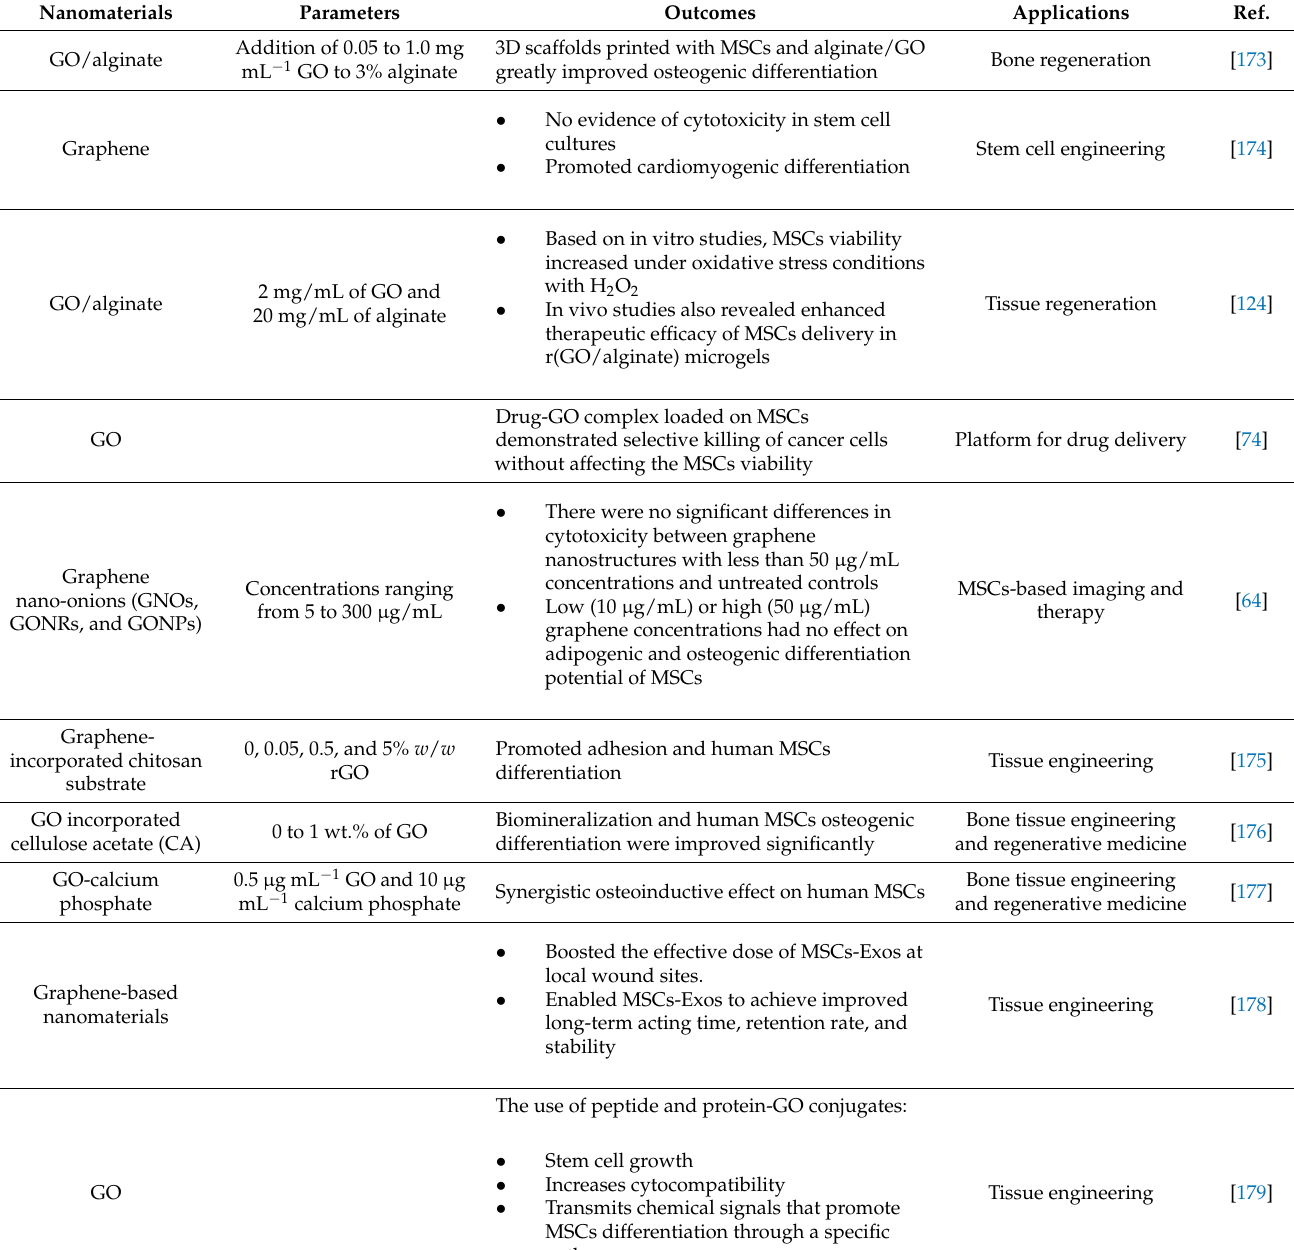
Table 3. Summary of GO based nanomaterials in